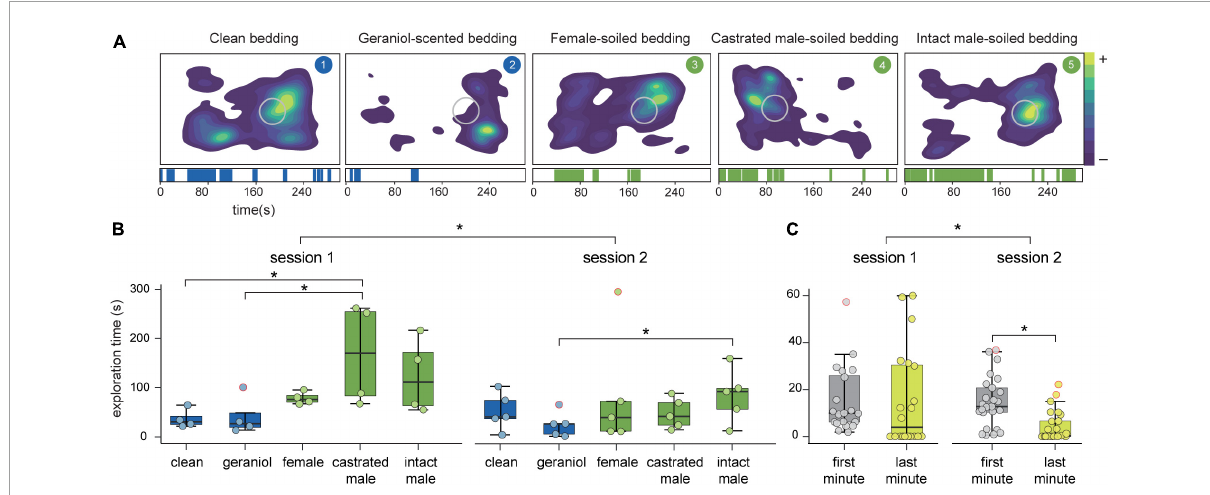
FIGURE2 Behavioral analysis. (A) Top: density plots of exploration of each stimulus from a representative animal. Region of interest is marked as a gray circle. Down: corresponding ethograms for each stimuli showing positive exploratory events through time (s). (B) Average exploration time (s) of each stimulus in each session and (C) in the first and last minute of each session. * p < 0.05. Box plots are defined in terms of minima and maxima by whiskers, and the center and bounds of box by quartiles (Q1–Q3). Outliers (dots with red border) were identified by Tukey method and left in the